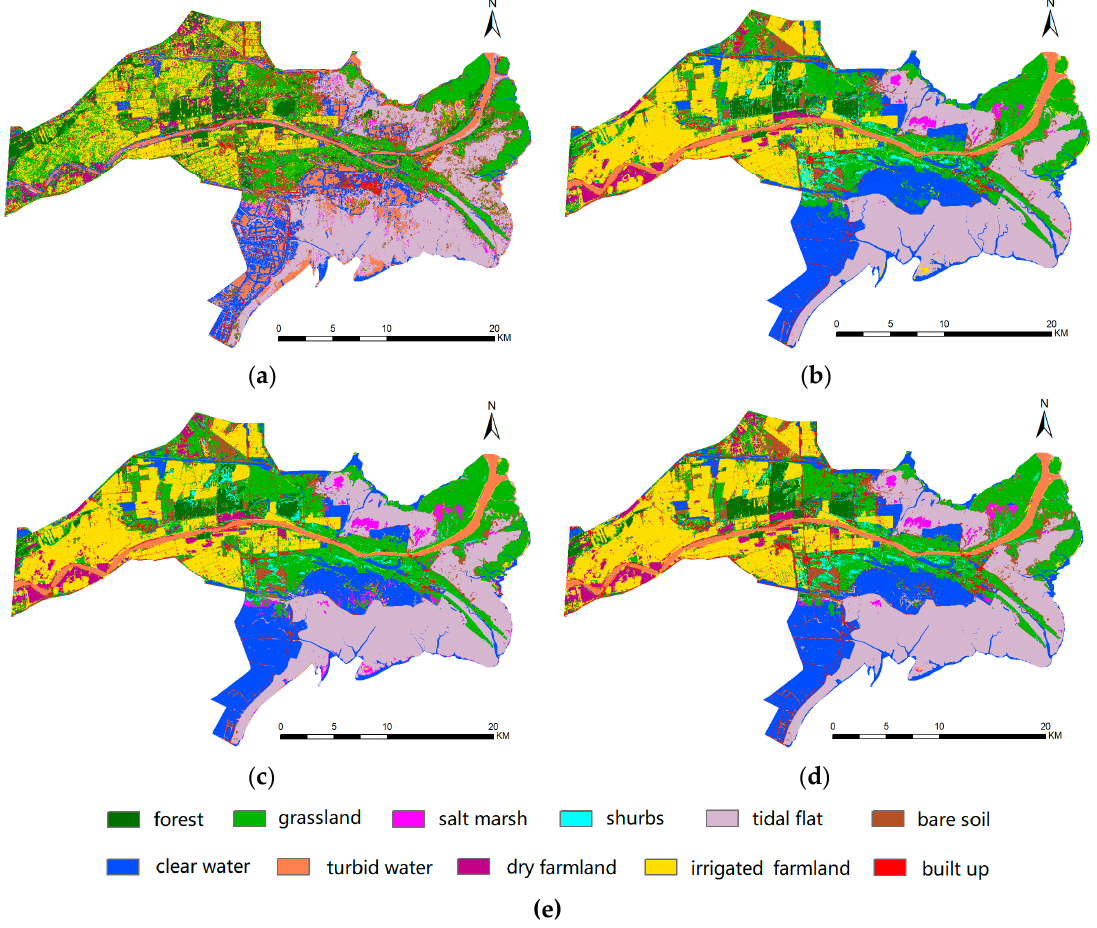
Figure 9. Classification results for the ( a ) radar-only, ( b ) optical-only, ( c ) feature-stacking, and ( d ) proposed multibranch CNN (MBCNN) classification models; ( e ) legend.